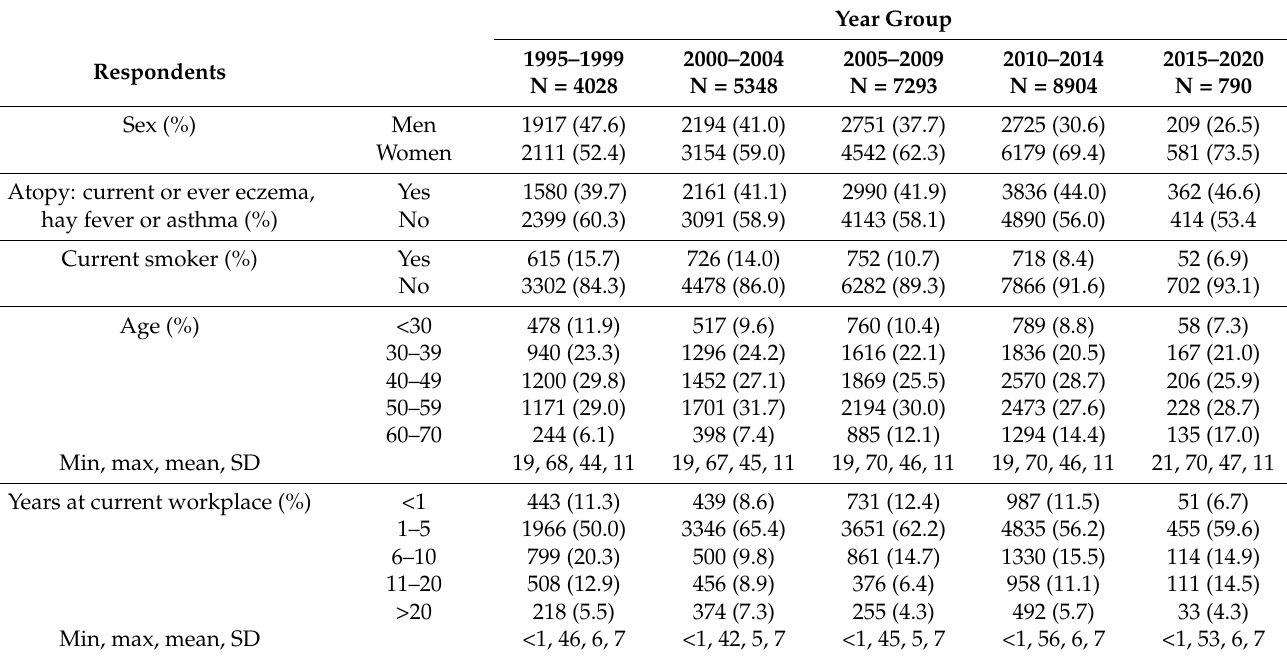
Table 1. General characteristics and statistics of questionnaire respondents divided into year groups. The sum of respondents is less than 26,477 and differs within year groups because of internal loss in the